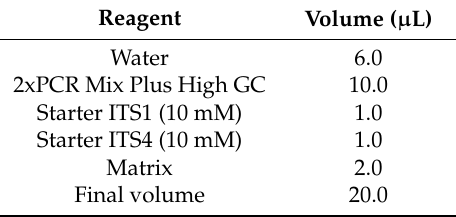
Table 3. Composition of the reaction mixture for the PCR (Polymerase Chain Reaction)